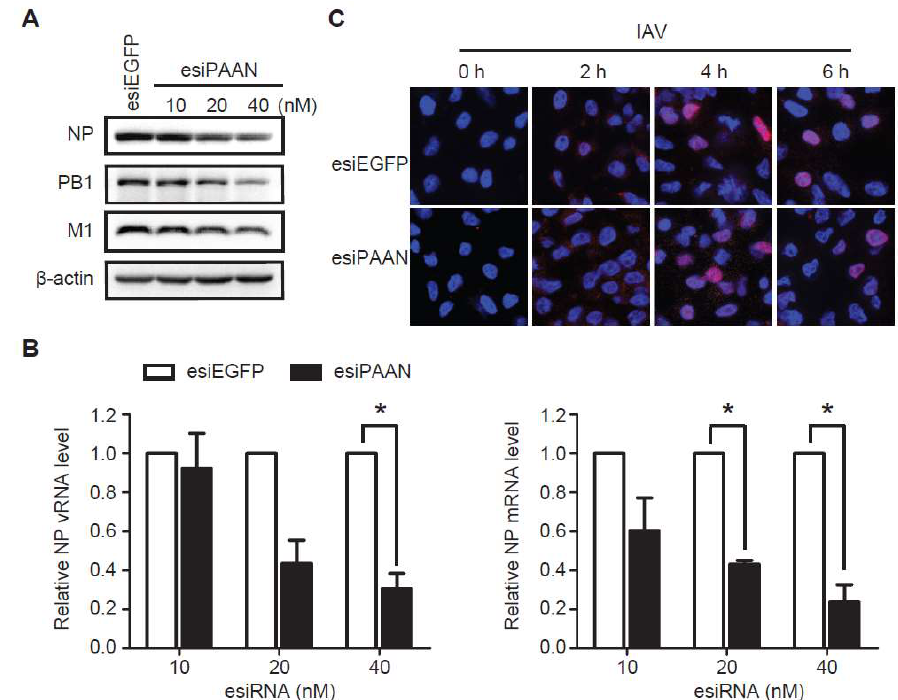
Figure 4. LncRNA-PAAN knockdown reduces viral RNA transcription and replication. ( A , B ) HEK293T cells were transfected with esiPAAN or esiEGFP, followed by infection with IAV (MOI = 0.5) for 24 h. Levels of viral NP, PB1 and M1 proteins were analyzed by western blot ( A ). Levels of vRNA and mRNA of the NP gene were determined by qRT-PCR. GAPDH mRNA was used as the internal control, and data are normalized to the control group with the value of control arbitrarily set as 1 ( B ). ( C ) HEK293T cells were transfected with esiPAAN or esiEGFP, then exposed to IAV infection (MOI = 3). At the indicated time points, cells were stained for nuclei (blue) and NP (red) in the indirect immunofluorescence assay. IAV means the WSN strain unless otherwise specified. *: p ≤ 0.05.